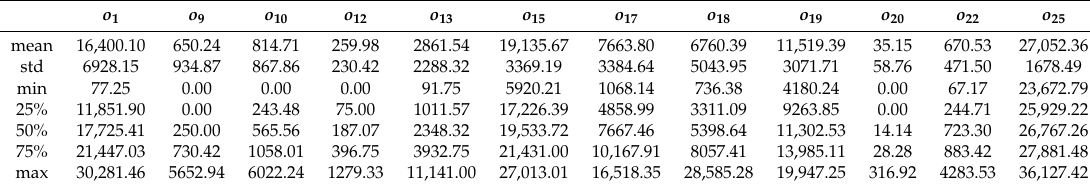
Table 3. Overview of the resulting crossing lengths for the 4667 Pareto-optimal solutions (corresponding to 12 of the 25 criteria). All values are in metres. Note: o 1 is a bundling criterion and thus represents the length along which no linear infrastructure corridors (existing power-lines) are